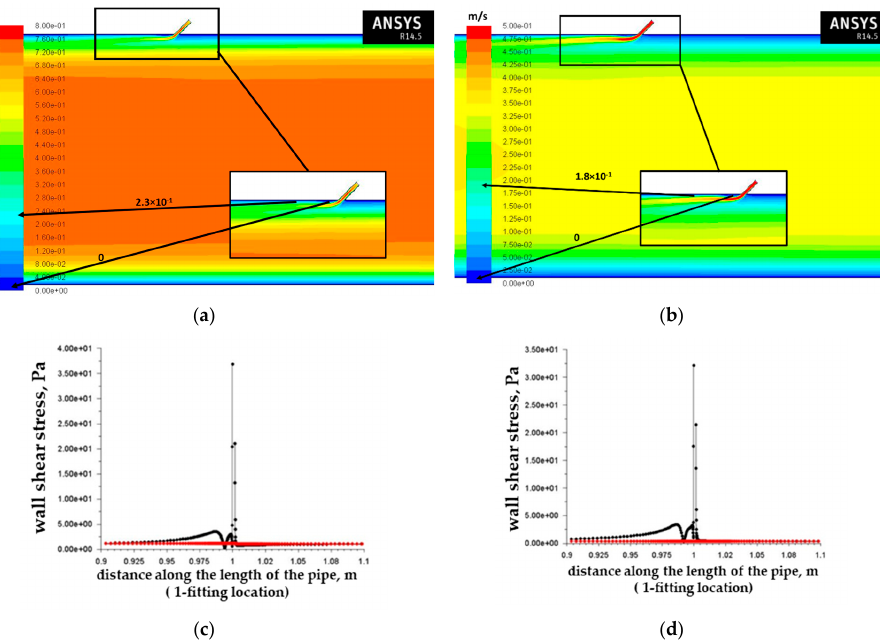
Figure 6. Velocity modulus field in the vertical section of the pipe for the variant of the nozzle-type ICD channel inclination angle of 4 5° and fluid velocity at the pipe inlet of 0.662 m/s ( a ) and 0.297 m/s ( b ); graphs of shear stresses on the pipe walls at 0.1 m from the nozzle of fluid velocity at the pipe inlet of 0.662 m/s ( c ) and 0.297 m/s ( d ). The black lines correspond to the wall on which the nozzle-type ICD is located, and the red lines correspond to the opposite wall.